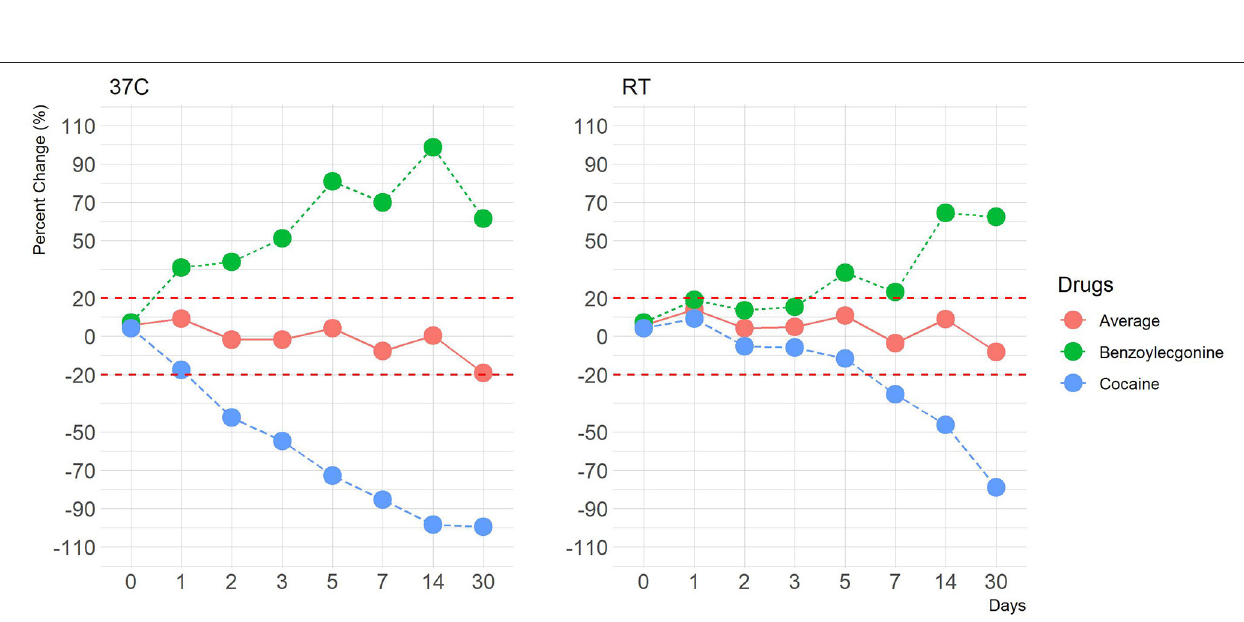
Frontiers in Toxicology |